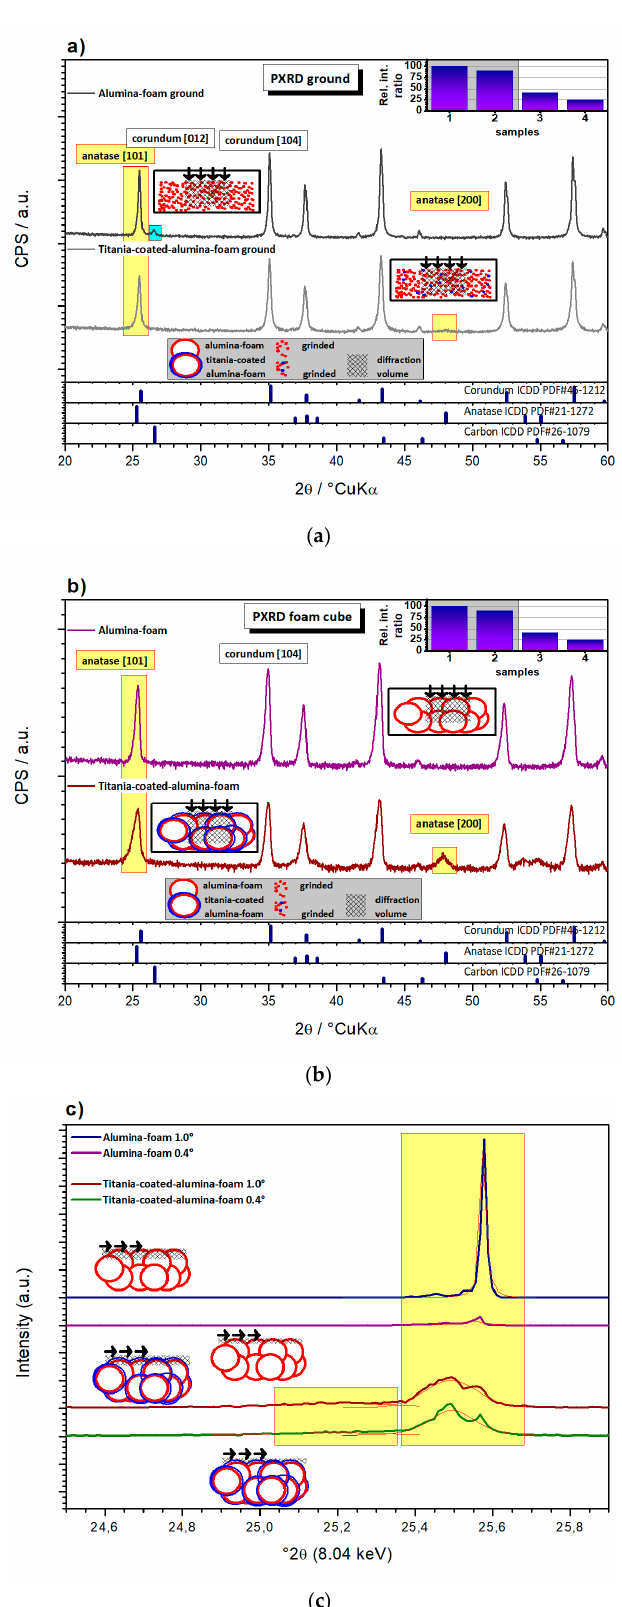
Figure 8. Al 2 O 3 foam and TiO 2 -coated Al 2 O 3 foam samples analyzed: ( a ) using Powder X-ray Diffraction (PXRD) on ground powders, ( b ) on bulk cubic samples and ( c ) using synchrotron radiation Grazing Incidence X-ray Diffraction (GIXRD) in thin-film measurement configuration.